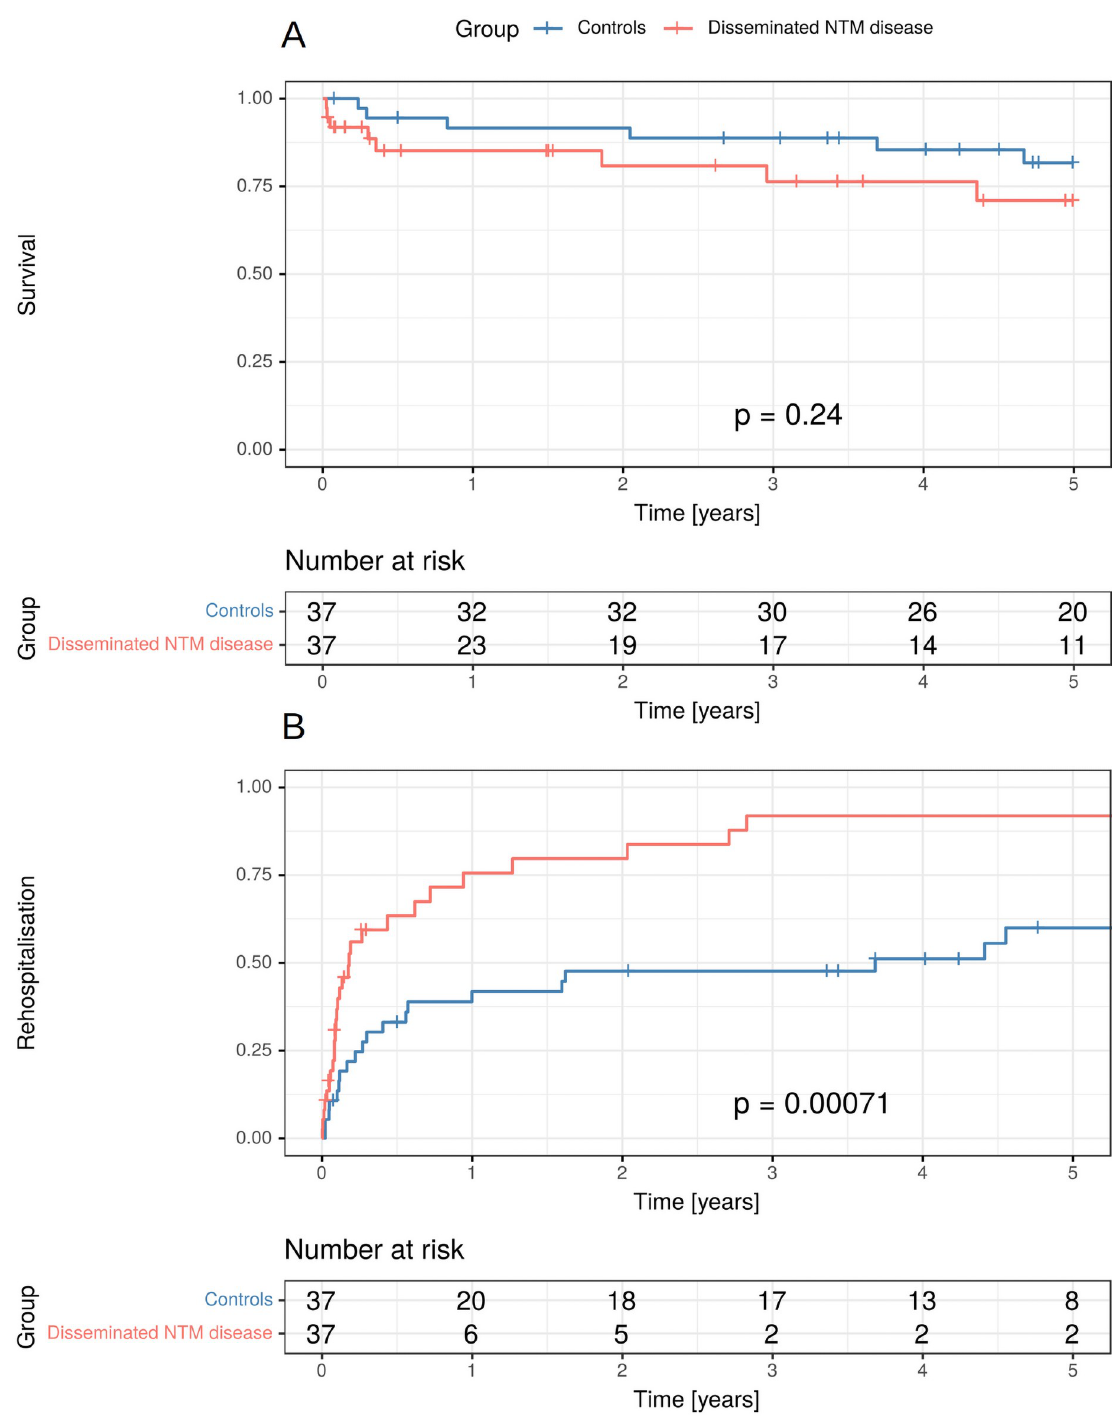
Fig 3. Survival analysis (A) and time to first rehospitalisation (B) in patients with disseminated NTM disease and controls. There was a non-significant trend to higher mortality in patients with disseminated NTM disease (p = 0.24). Time to rehospitalisation was significantly shorter in those patients (p <